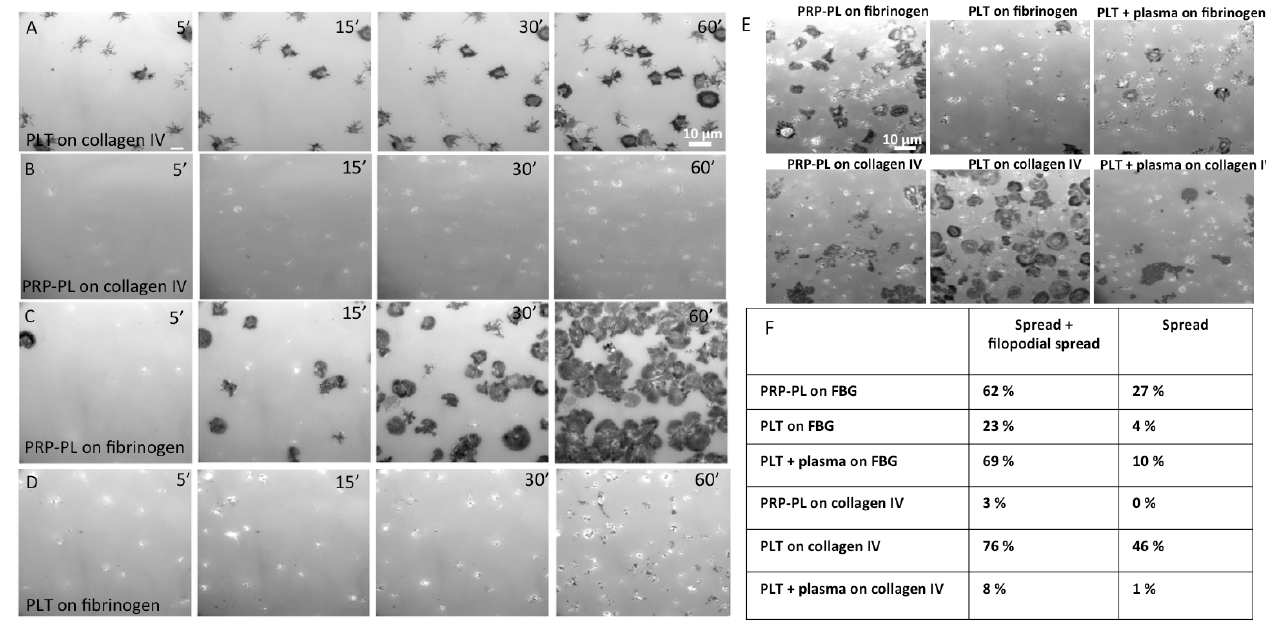
Figure 6. Platelet dynamics on fibrinogen and collagen IV surfaces. ( A – E ) IRM imaging of platelet spreading for 1 hour. Scale bar: 10 μm. ( A ) PLT spreading on collagen IV surfaces. ( B ) PRP-PL spreading on collagen IV. ( C ) PRP-PL spreading on fibrinogen. ( D ) PLT spreading on fibrinogen. ( E ) PRP-PL and PLT spreading on fibrinogen and collagen IV, with and without the addition of plasma to the PLT, 1 hour post- platelet seeding. ( F ) Percentage of platelets in each morphological state, 1 hour post-platelet